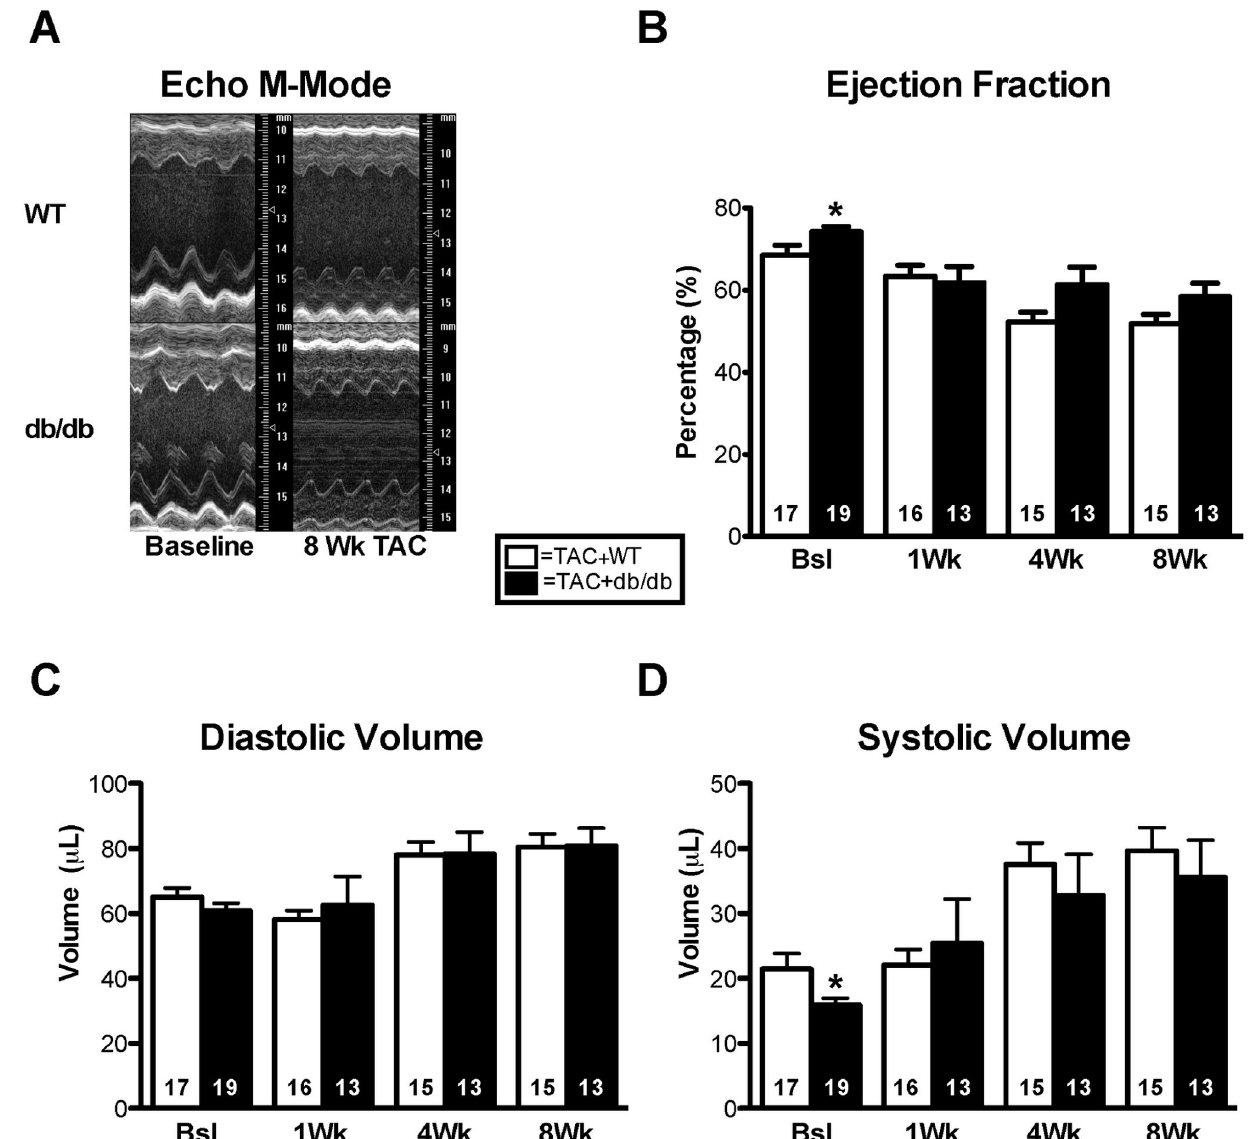
Figure 6. Hyperglycemia does not affect progression of pressure overload induced cardiac dysfunction. ( A ) Long axis m- mode utilizing the Vevo 770 imaging system. ( B - D ) Ejection fraction was not significantly changed from control groups through eight weeks of TAC. Diastolic and systolic volumes did not differ between the TAC+db/db and the TAC+WT groups. Results are expressed as means ± S.E., *, p< 0.05.